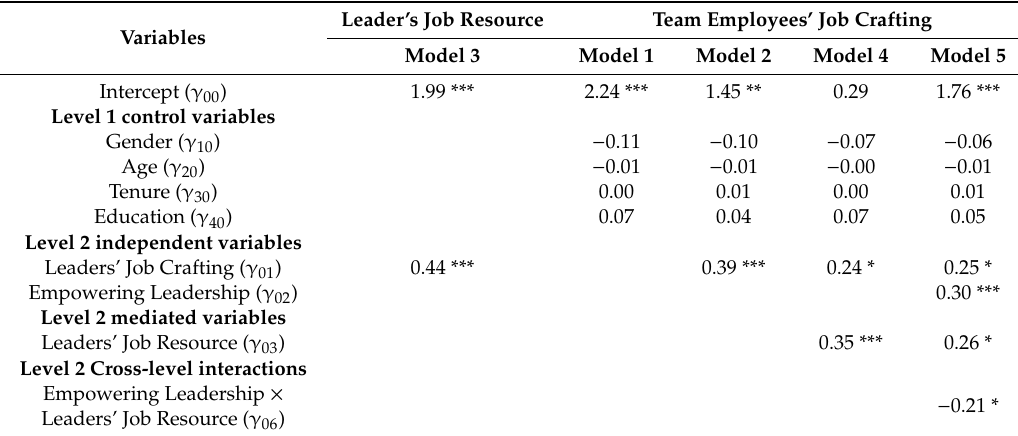
Table 2. Hierarchical linear modeling (HLM) results: Main and interactive e ff